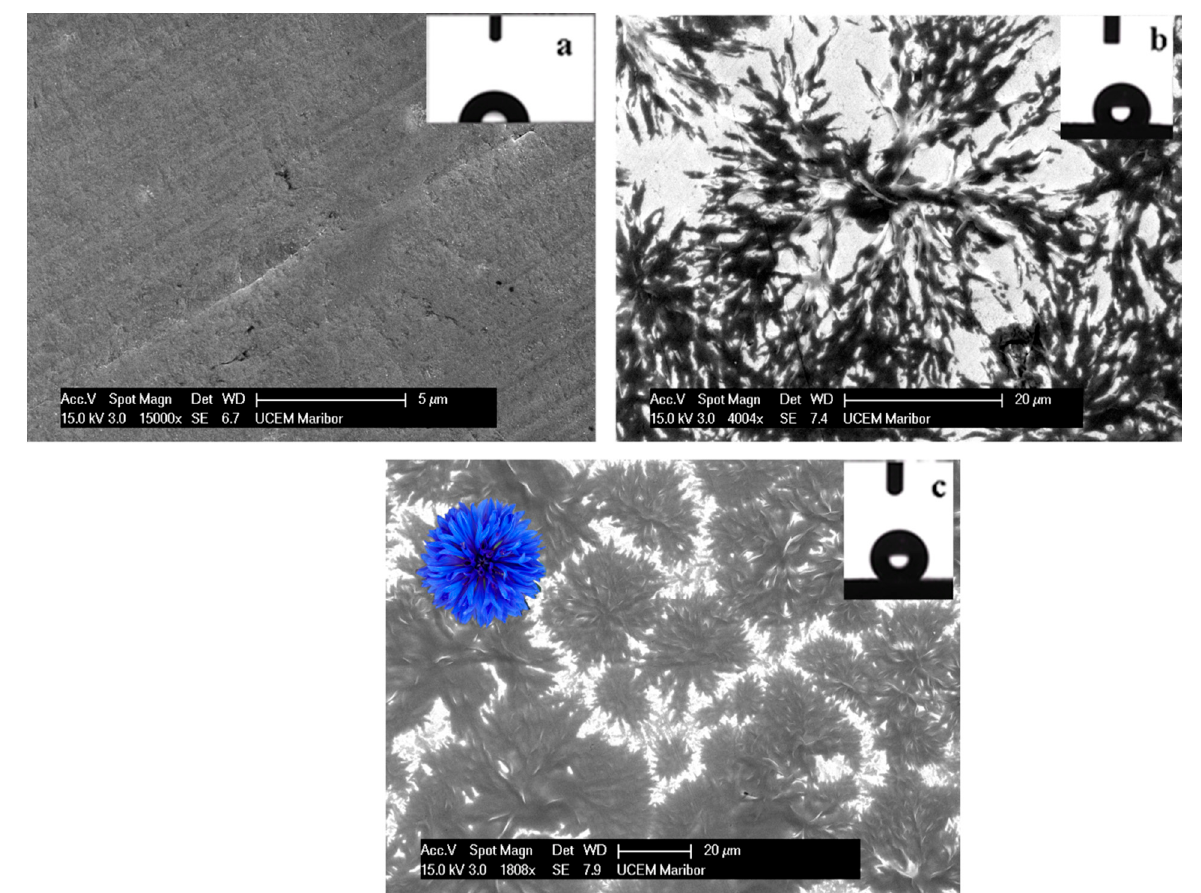
Figure 1. SEM of the untreated and modified surface of SS type AISI 410S. ( a ) Untreated and etched surface (CA = 71.5° ± 3). ( b ) Modified surface in an SA solution for one hour (CA = 122.8° ± 2). ( c ) Modified surface in an SA solution with the addition of 2.0 wt% of E307 for one hour (CA = 138.7° ± 3) [ 27 ] .